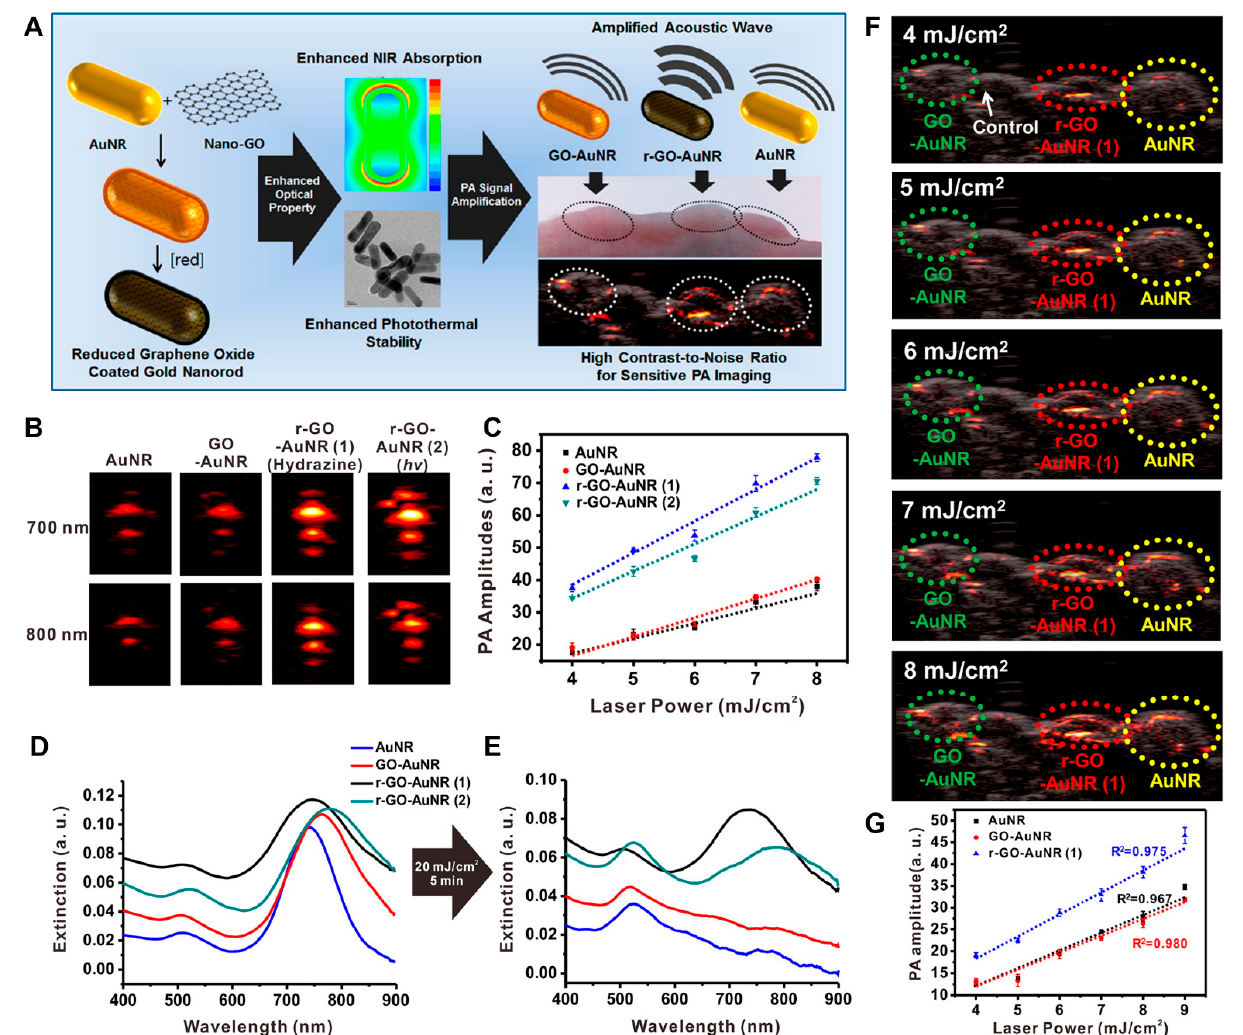
Figure 5. rGO–AuNRs for PAI application. ( A ) Synthesis and characterization of rGO–AuNRs and in vivo mouse PAI. ( B ) Representative PA images obtained at 700 and 800 nm laser irradiation and ( C ) corresponding PA amplitude. UV–visible spectra ( D ) before and ( E ) after laser illumination for 5 min (20 mJ/cm 2 , 10 Hz). ( F ) PA images visualized after illumination with different input laser powers that ranged from 4 to 8 mJ/cm 2 in living mice. ( G ) Quantitative analysis of photoacoustic signal intensities obtained with each group. The images are reproduced with permission from ref. [103].